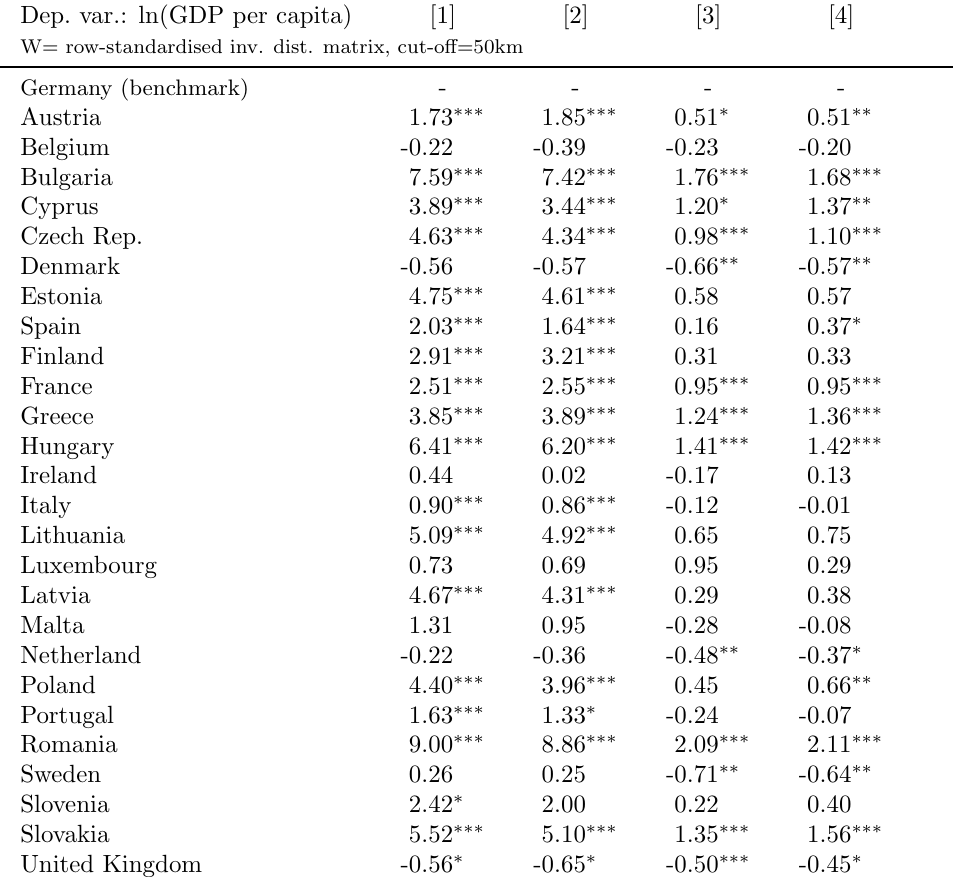
Table A.1: Empirical Results - Random effect - EU sample country dummy coefficients (total